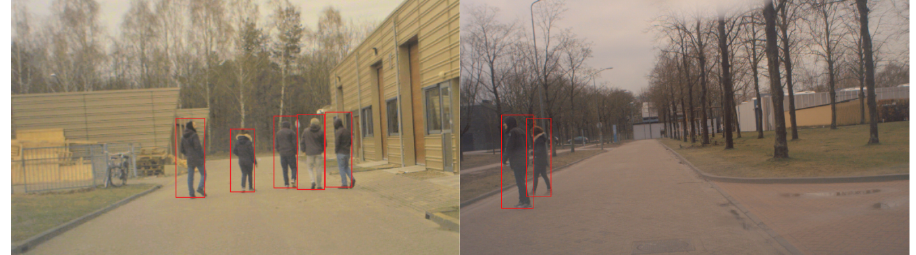
Figure 9. Illustration of our experimental test. The car receives the center of each rectangle as the position of